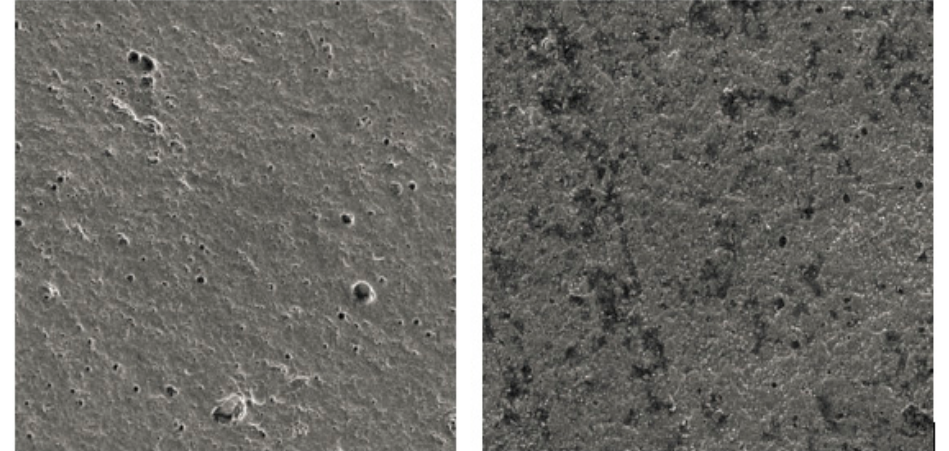
Figure 3. Image of dirties on the surface of tested PVD coating after cutting edge preparation (dark areas) Left—abrasive jet machining, Right—Drag finishing.